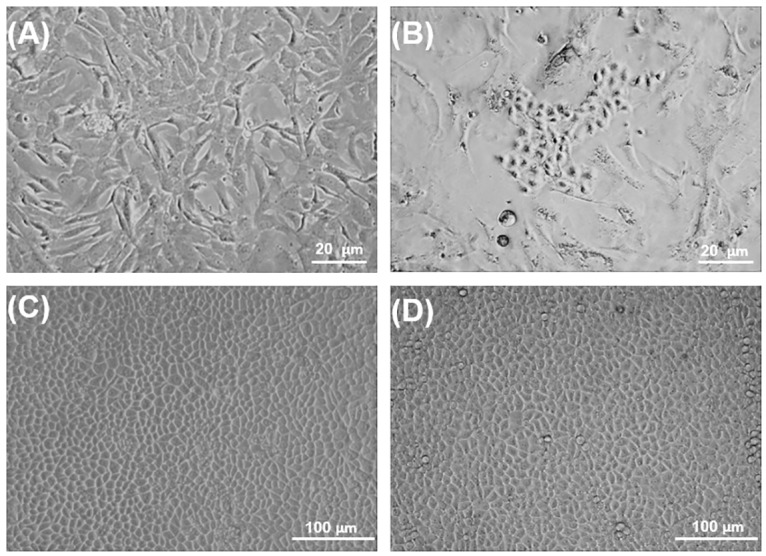
Morphology of the DEE cell line at different stages of the culture process.(A) Initial culture of the goose embryo tissue. (B) After several treatment of primary culture with collagenase, tightly packed epithelial-like cell colonies were observed. (C) Existence of cells with epithelial-like morphology after serial passages. (D) After freezing and thawing, the DEE cell line displayed a uniform shape of the epithelial cells.